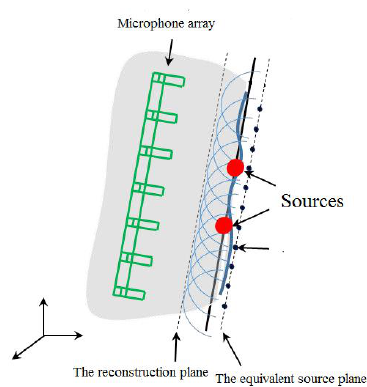
Figure 1. The diagrammatic sketch of the equivalent source method (ESM).